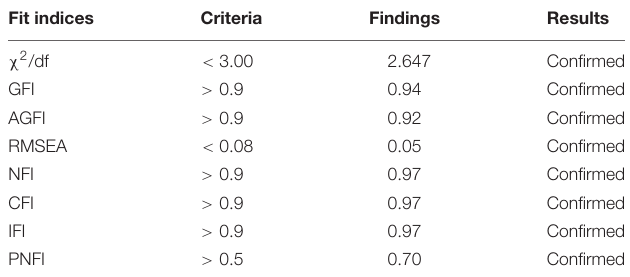
TABLE 4 | Fit indices of structural